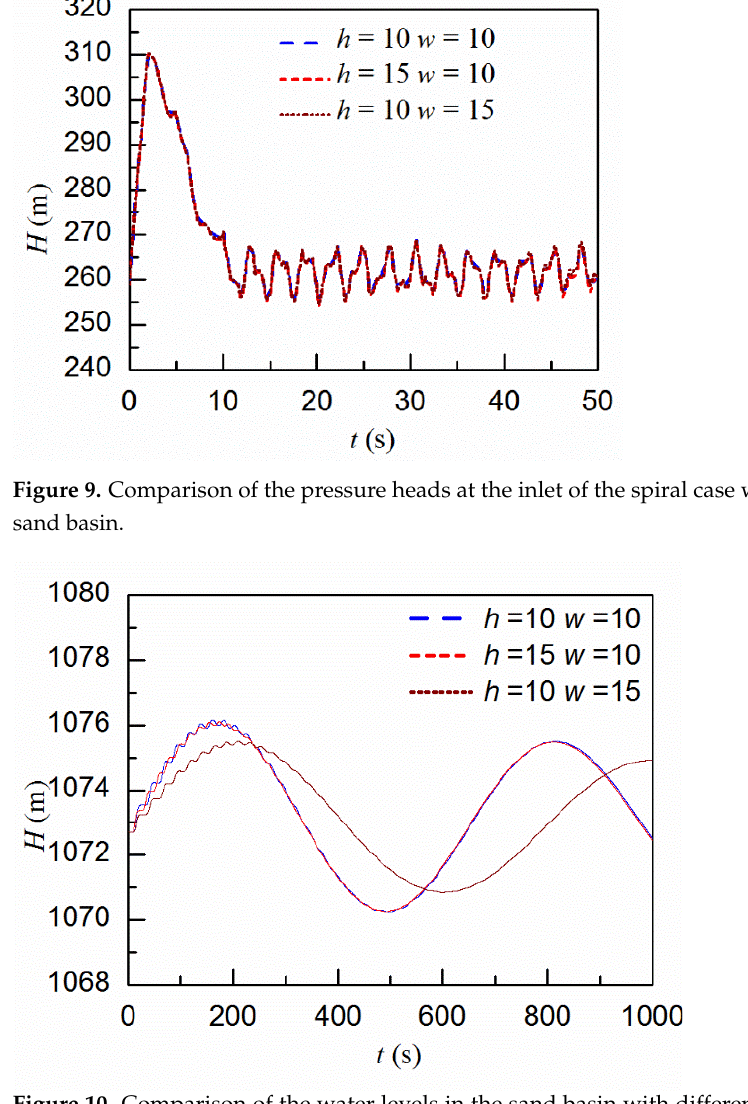
Figure 11. Comparison of the water levels in the sand basin at different positions ( L 1 = 2400 m, h = 10 m, w = 10 m). 4.2.2. Comparison with the Results by Modelling the Basin Tank as a Surge Tank In the previous section, the sand basin is treated as an open channel which is mod ‐ elled using the FVM. Another modelling method of the sand basin is to simplify it as a surge tank in the hydropower station. With the length of 250 m and width of 10 m for the sand basin, the equivalent area of the surge tank used to model the sand basin is calculated as 2500 m 2 . The simulated results by treating the sand basin as a surge tank and those by